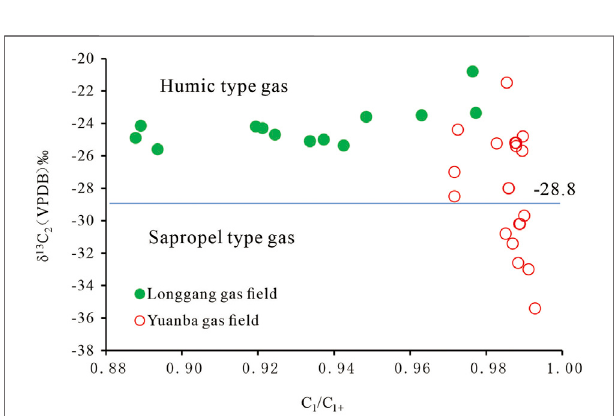
FIGURE 9 | Relationship between C 1 /C 1+ and δ 13 C 2 of T 3 x gas in Longgang and Yuanba gas fi elds.